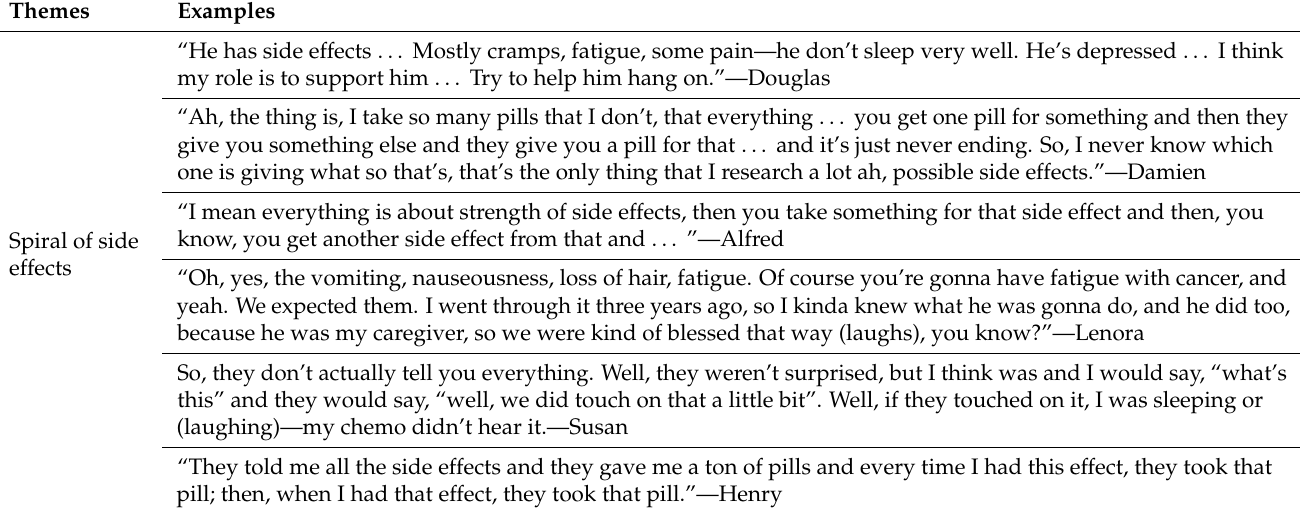
Table 3. Themes and Exemplar